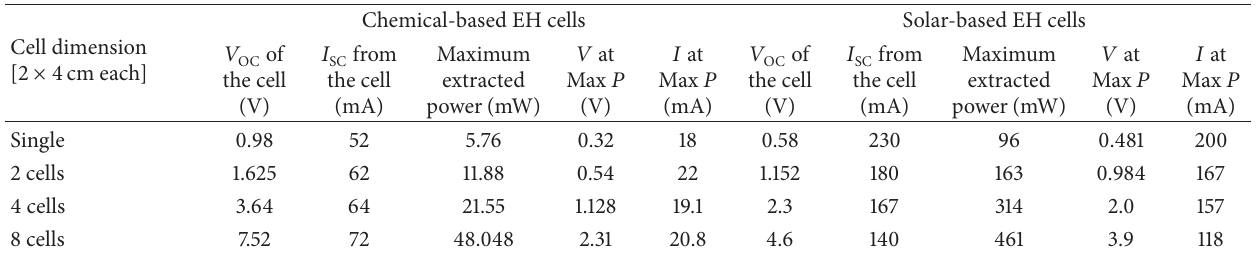
Figure 5: Experimental setup to proof-of-concept of chemical-based EH. (a) EH cells are connected with SMU. (b) Photograph of developed chemical-based EH cells connected serially. Table 3: Power producing capabilities of chemical- and solar-based EH cells.